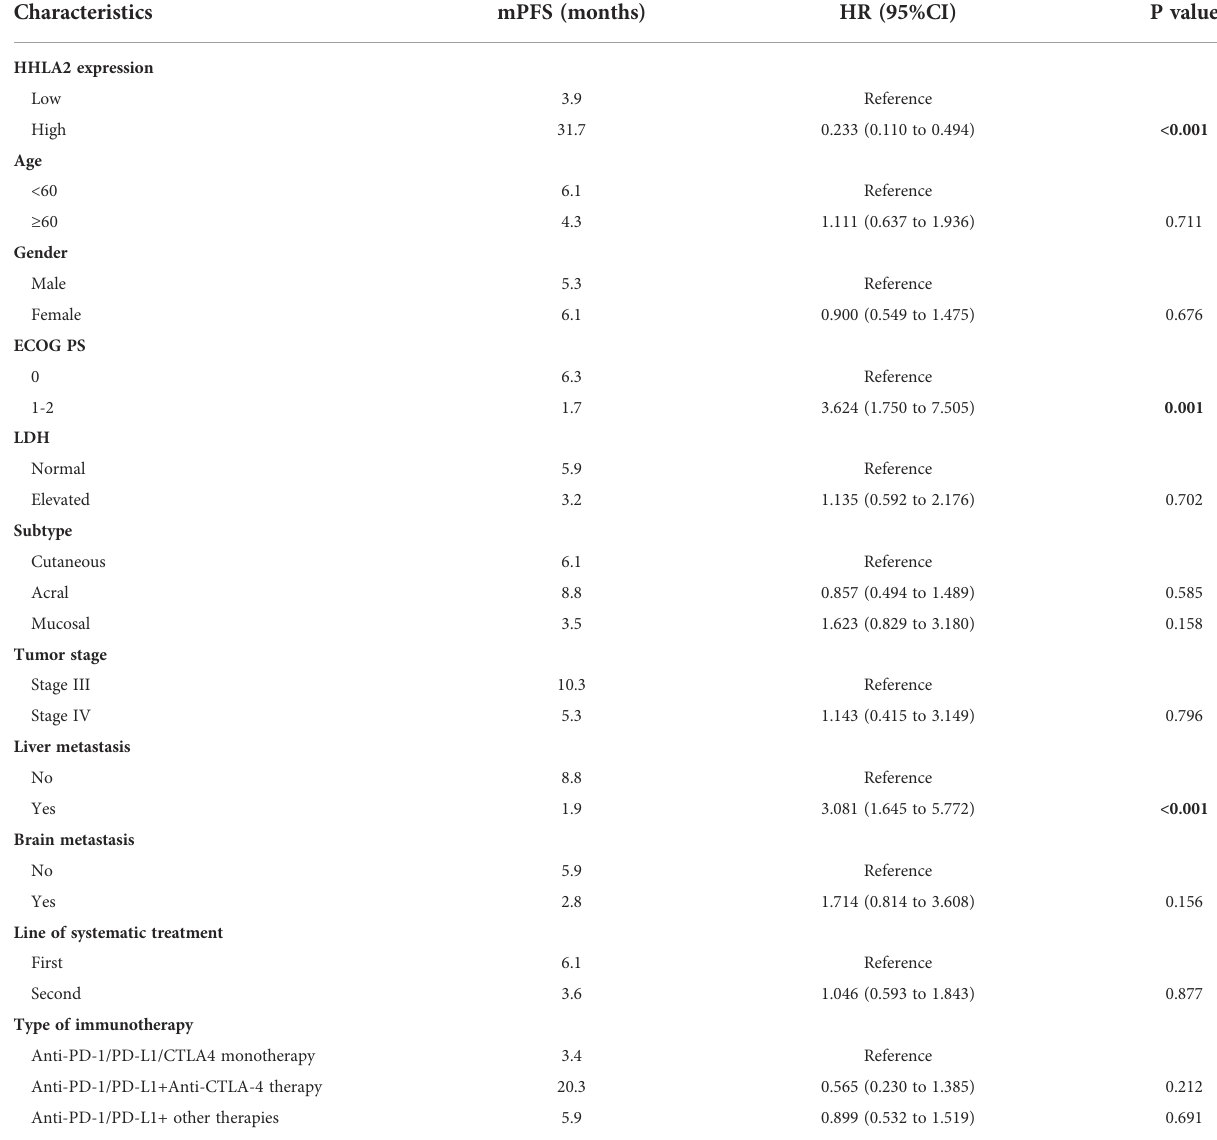
TABLE 2 Univariate analysis of prognostic factors correlated with PFS.